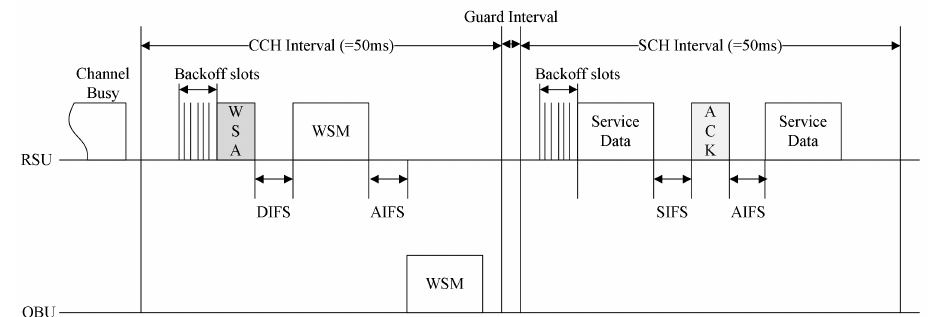
Figure 1. The channel structure in the WAVE